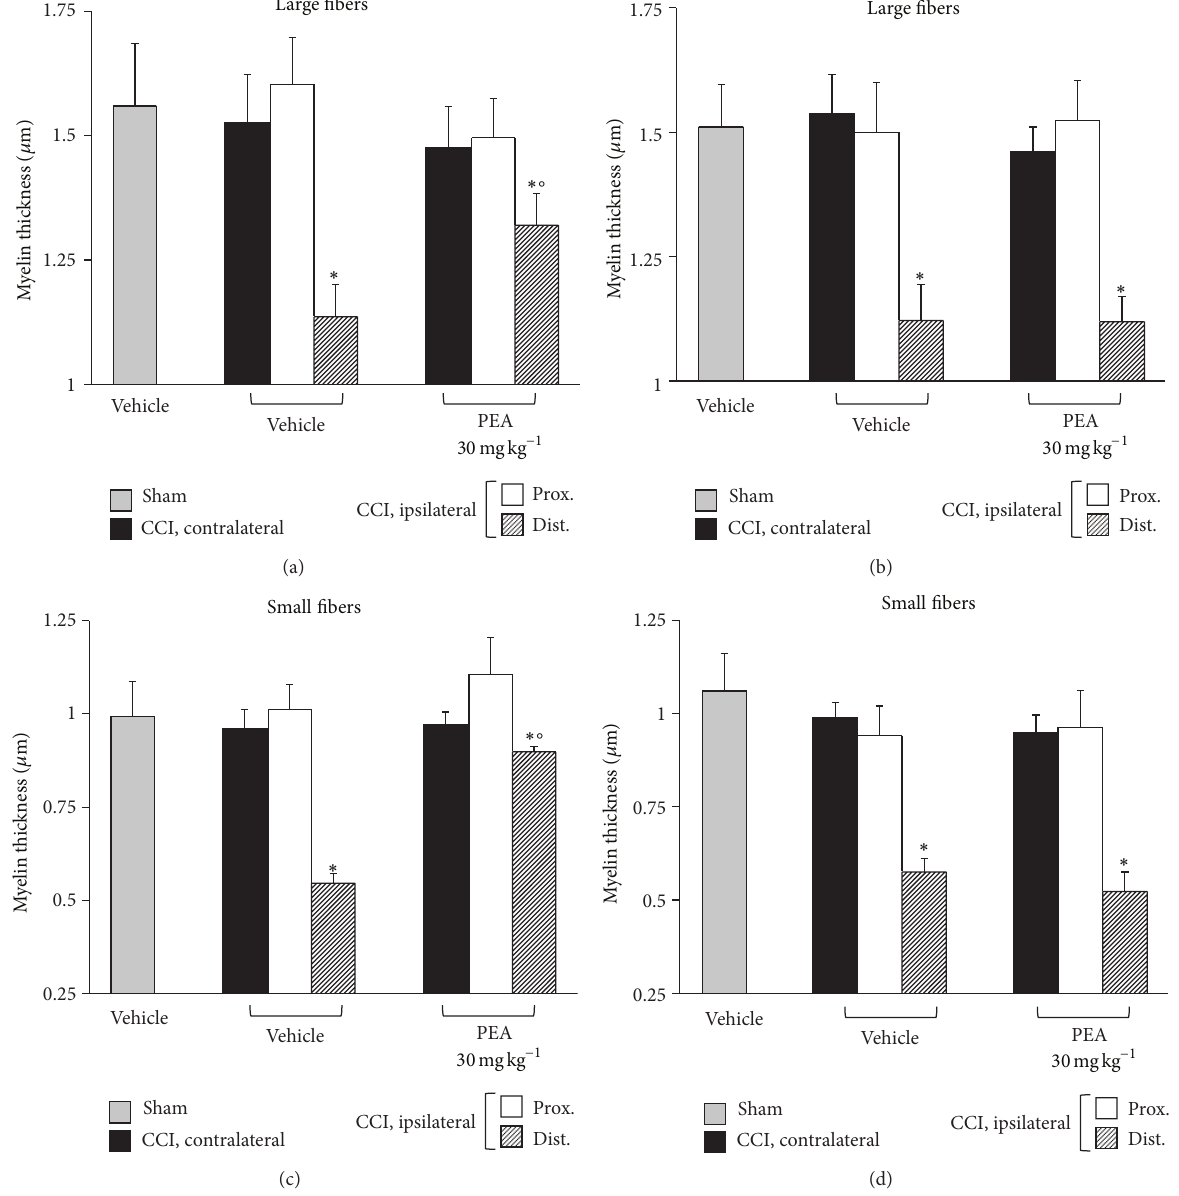
Figure 3: Morphometry: myelin thickness. Nerve sections (5 𝜇 m) of osmium-fixed tissues were analyzed. The distal and the proximal tract of the ipsilateral ligated nerve (CCI) was compared with the contralateral and with the sciatic nerve of sham-operated animals (sham). Myelin thickness of large and small fibers of PEA-treated (30mg kg −1 s.c. for 14 days) PPAR- 𝛼 +/+ ((a) and (c)) and PPAR- 𝛼 −/− ((b) and (d)) mice in respect to saline-treated CCI and saline-treated sham animals. Quantitative analysis was performed evaluating 5 animals for each group. ∗ 𝑃 < 0.05 was considered as significantly different from sham, vehicle-treated mice. ∘ 𝑃 < 0.05 was considered as significantly different from CCI, vehicle-treated